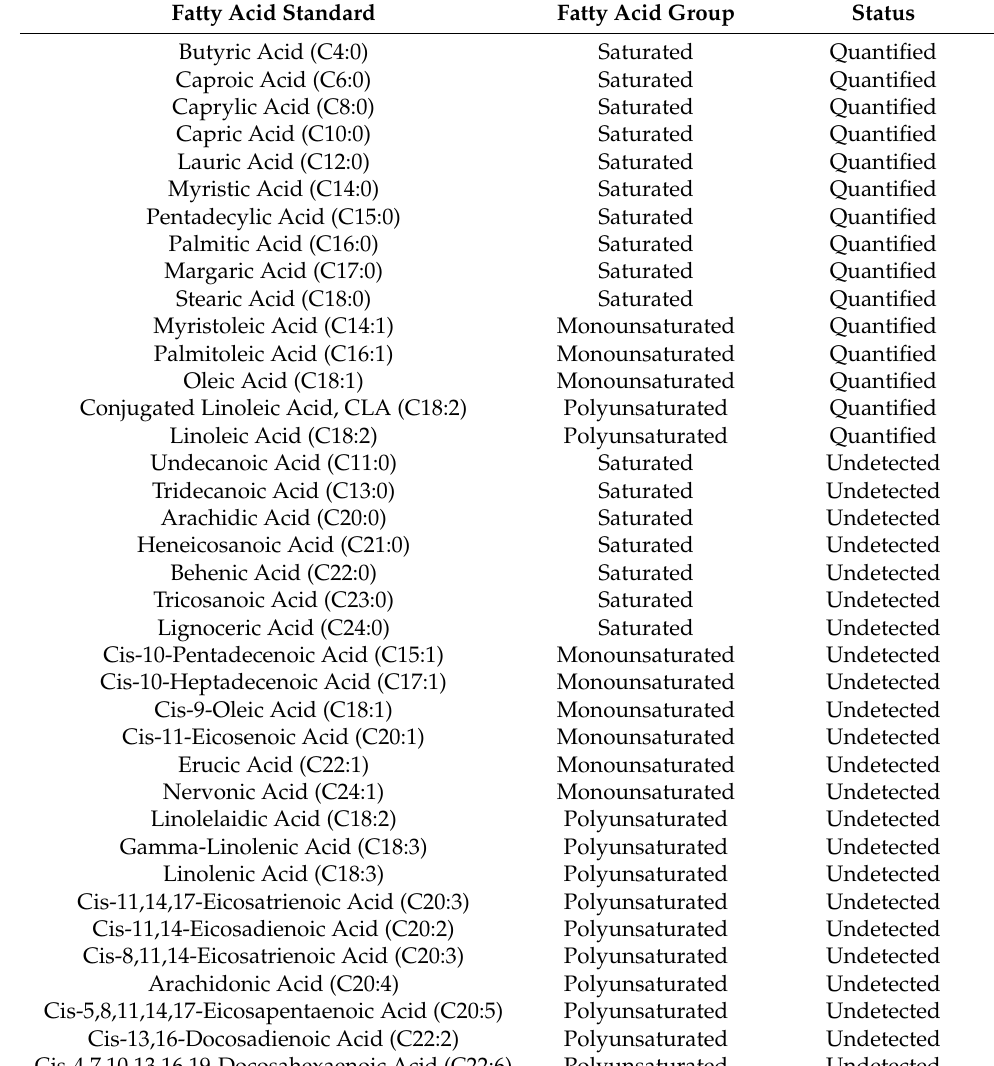
Table A2. Composition of the fatty acid standard mix (Merck, 18919-1AMP) and their detection and